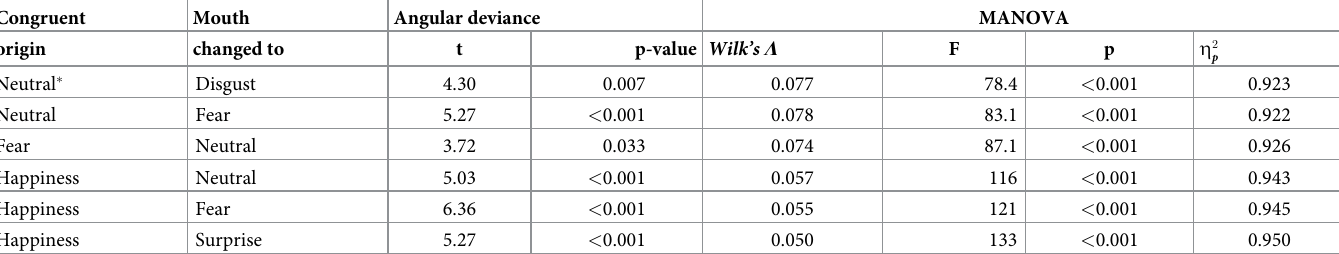
Table 1. Statistical test results of the significant deviations (see asterisks in Fig 3A) caused by changing mouth expression from a congruent expression. Bonferroni correction has been applied to all p-values. In MANOVAs df = 4,26 in the condition marked with � , df = 4,28 in all others. All pairwise differences (post-hoc tests in MAN- OVAs) are statistically significant (p <